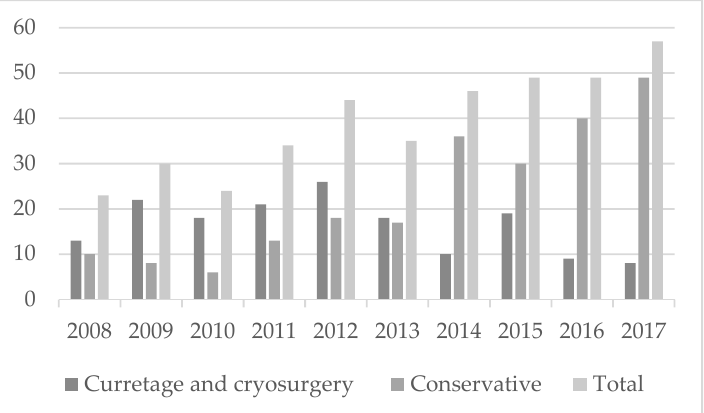
Figure 1. Number of cartilaginous tumors without aggressive characteristics located in the long bones treated at our institution between 2008 and 2017.